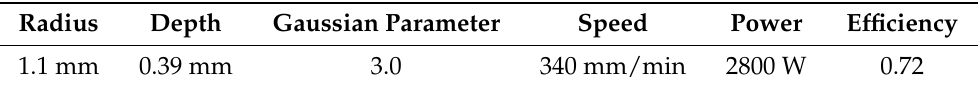
Table 3. Specifications of the normally distributed area heat source for the laser process in the simulation model.